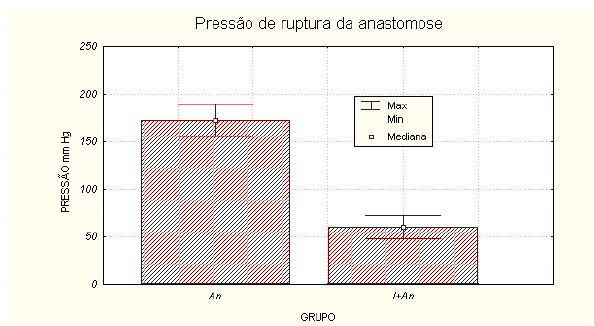
FIGURA 3 - Variação da pressão de ruptura da anastomose nos grupos estudados (p = 0,004).